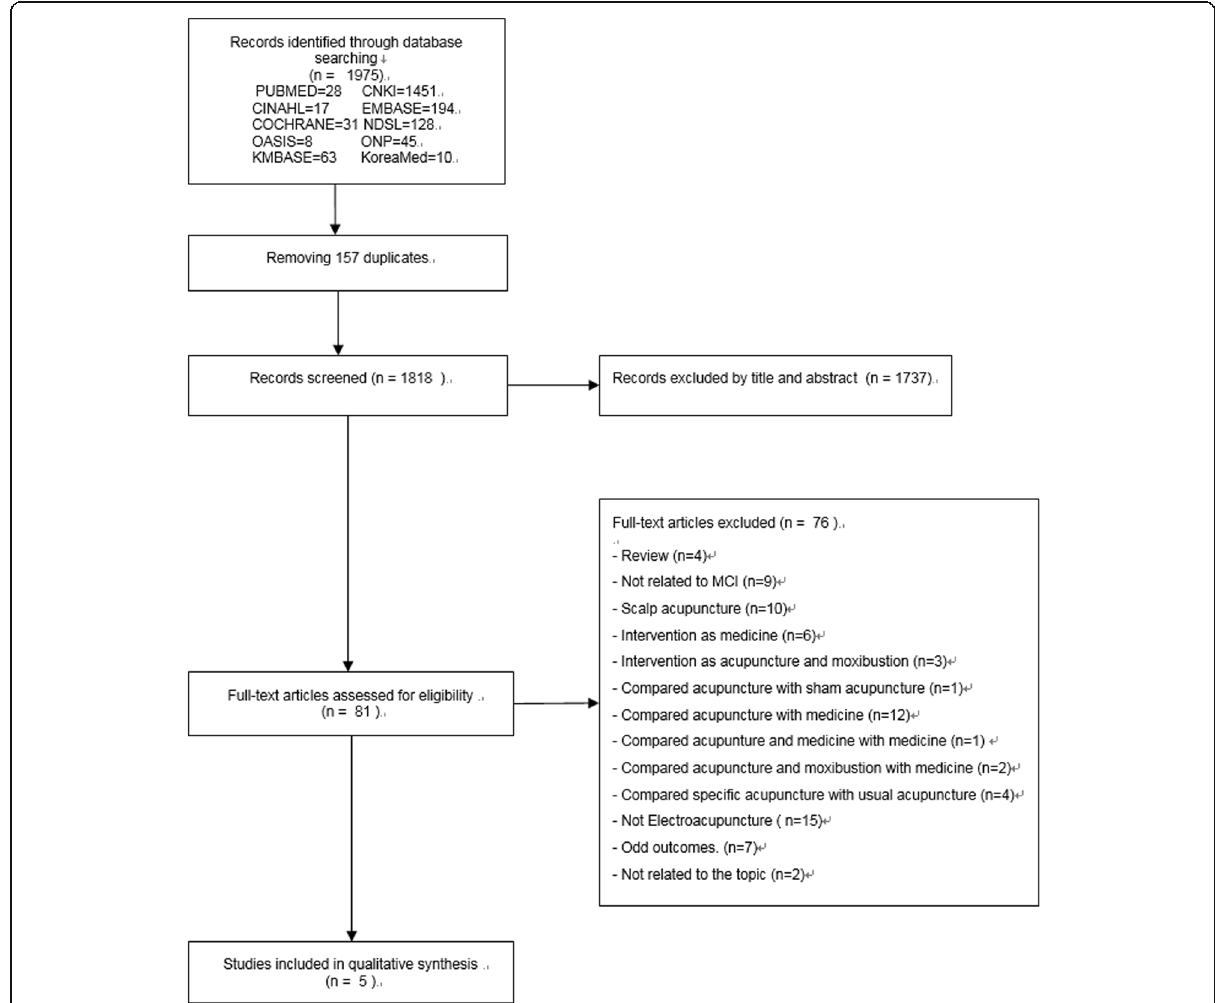
Fig. 1 Flow-chart of studies included in the meta-analysis on effect of electroacupuncture to MCI